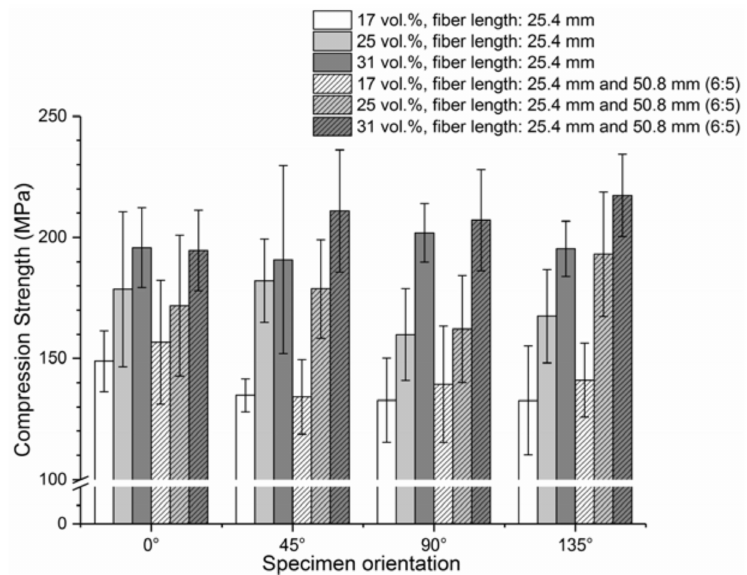
Figure 6. Compression strength of different SMC materials in different directions with respect to the movement of the conveyor belt.